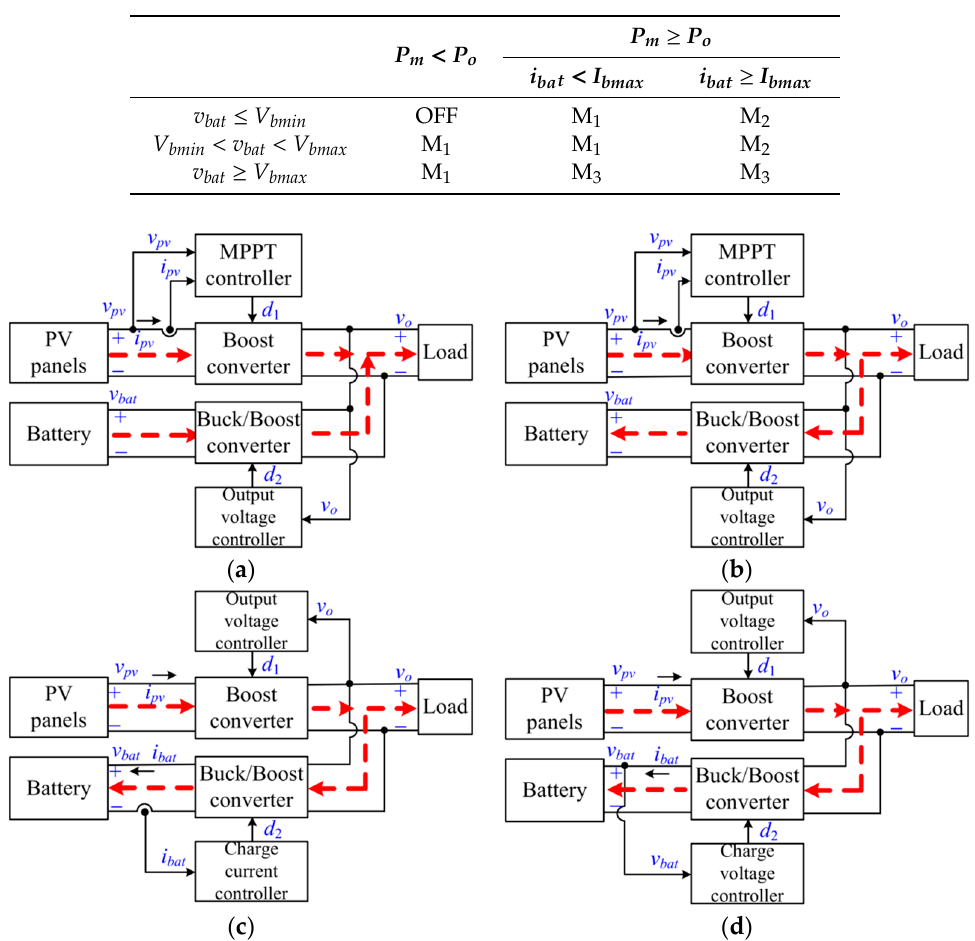
Figure 2. Power flow schematics and corresponding control requirements of PVDCM, which operates in: ( a ) M 1 with P m < P o ; ( b ) M 1 with P m > P o ; ( c ) M 2 ; ( d ) M 3 .